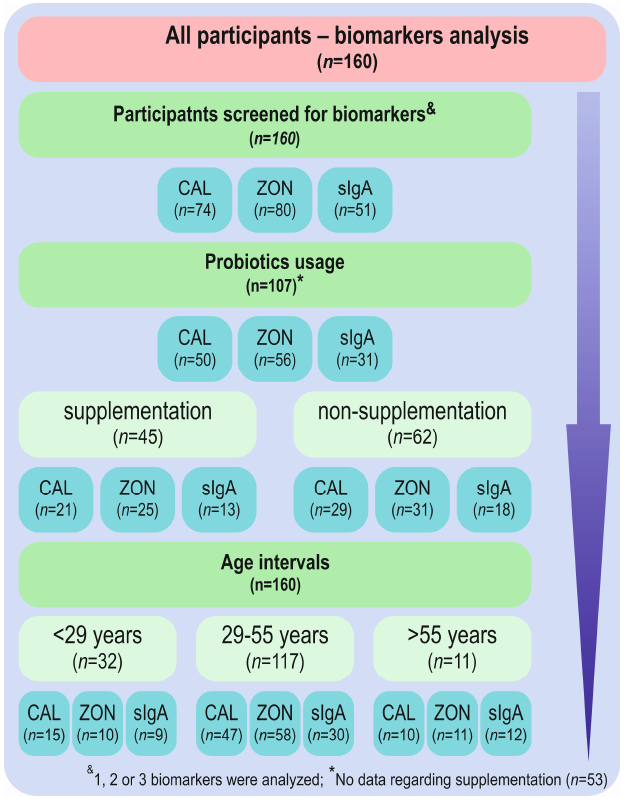
Figure 1. Study flow chart. CAL—calprotectin; ZON—zonulin; sIgA—secretory immunoglobulin A; n —number of studied cases.